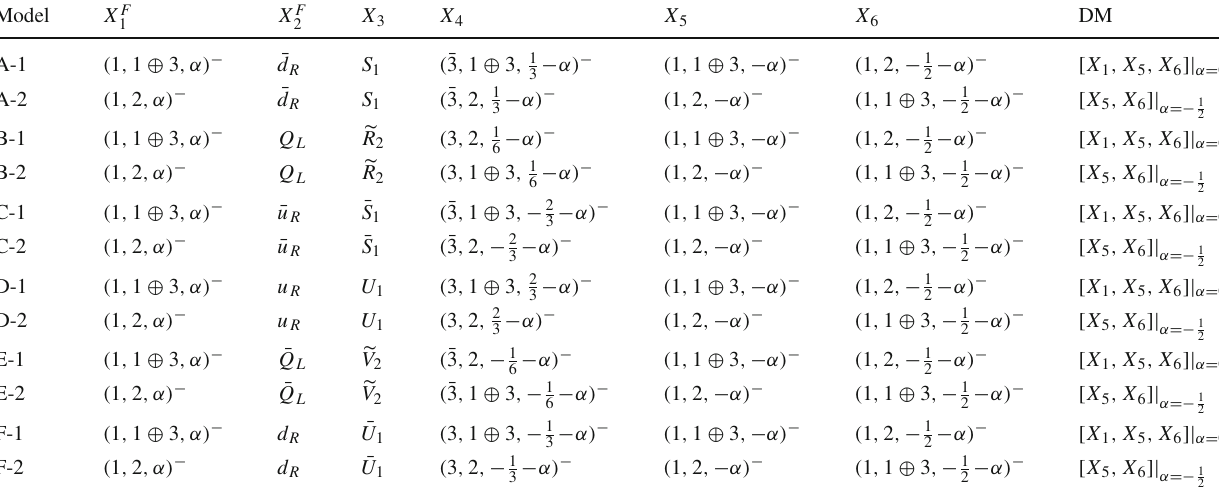
Table 9 Same as in Table 4 but for the diagram T3-ii depicted in Fig. 3 and with the combination (b)-(B) shown in Fig.